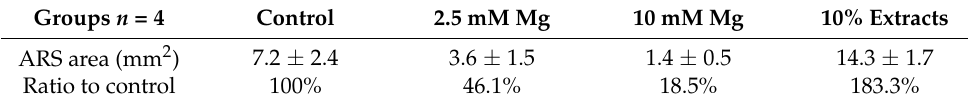
Table 1. Alizarin Red staining positive area.